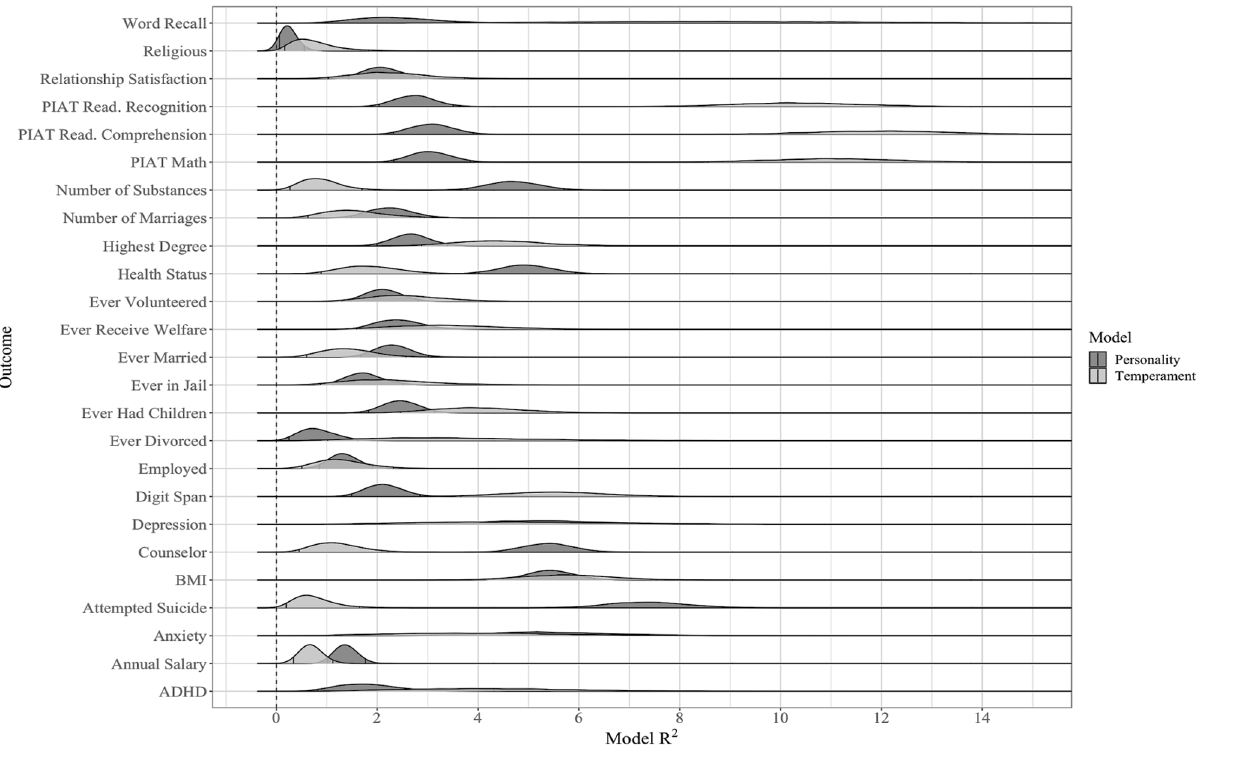
Figure 1. R 2 distributions from the temperament-only and personality-only models for all outcomes. R 2 distributions for temperament- and personality-only models are presented above for all outcomes. R 2 values are presented as percentages. The R 2 for the temperament-only models is plotted in light gray. The R 2 for the adult- based personality-only models is plotted in dark gray. The 95% credible intervals, representing the R 2 values that were present in 95% of the posterior distributions, are outlined in each